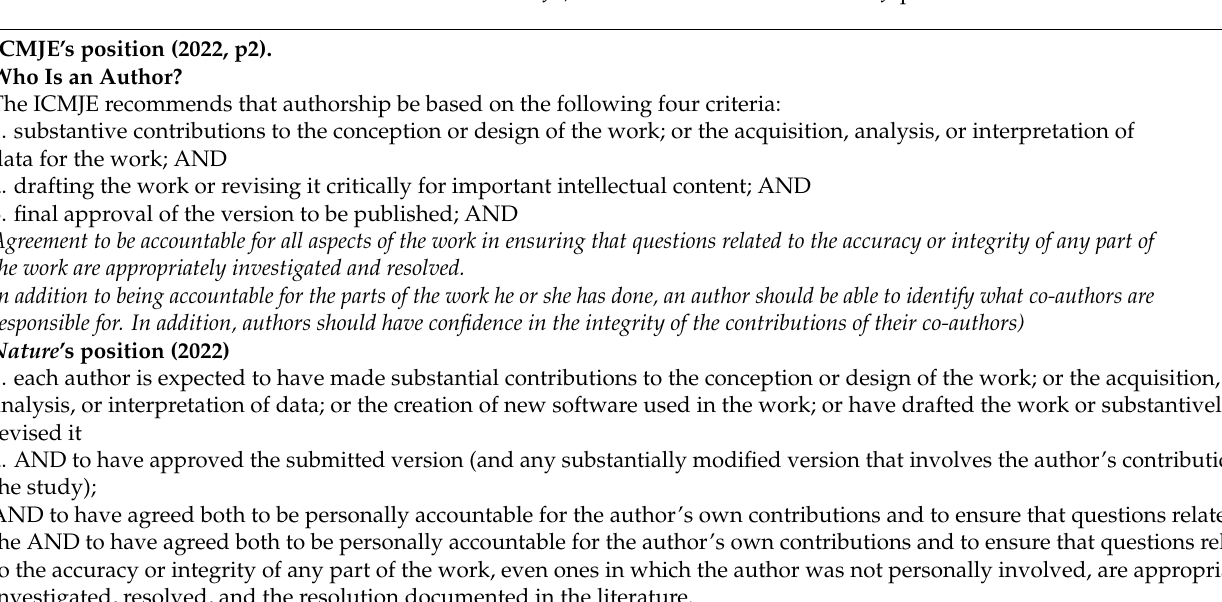
Table 2. Position of ICMJE, Nature and Science Council of